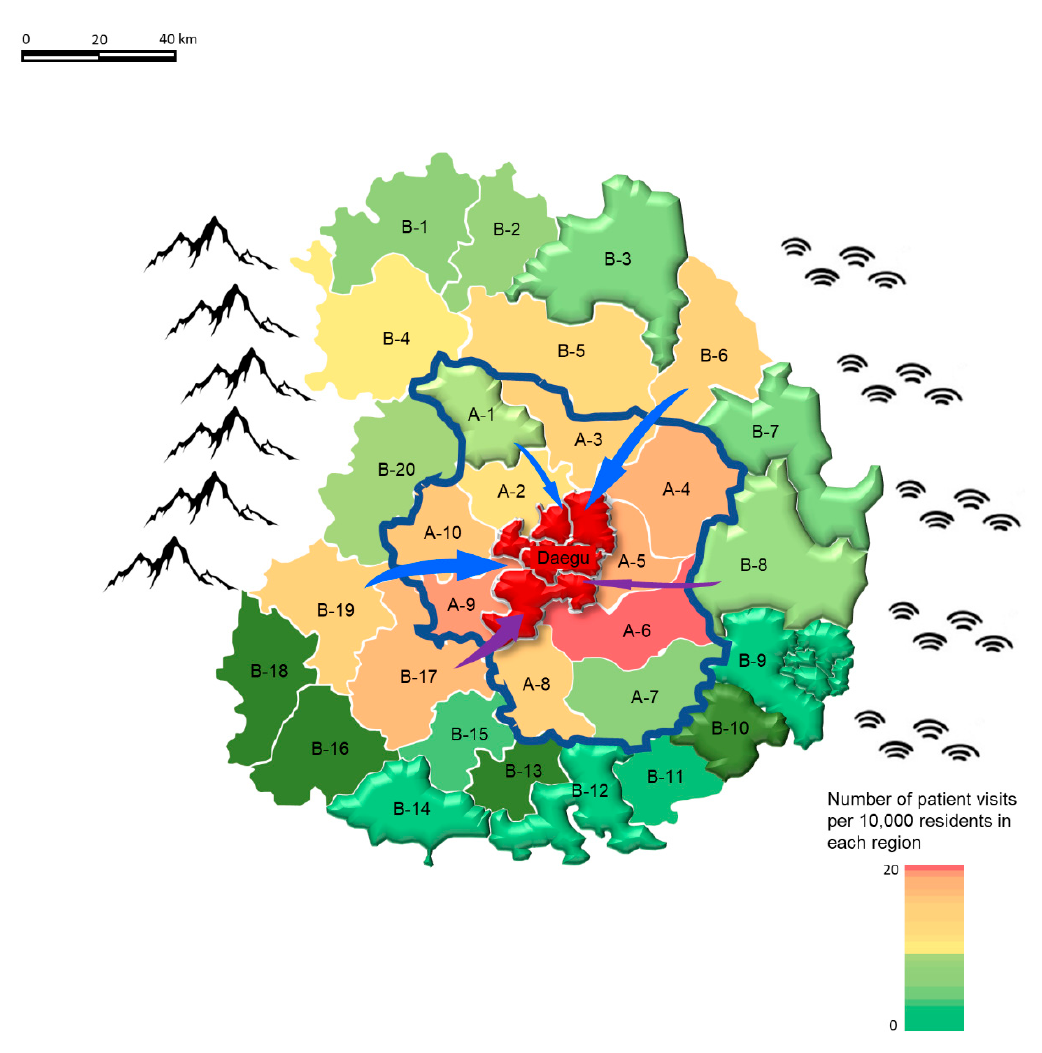
Figure 2. Number of patient visits per 10,000 residents in each region outside the metropolitan city. (Among the neighboring provinces, areas less than 45 km away from the Daegu Metropolitan City are marked as “A”, and those farther than 45 km are marked as “B”. Each subregion within A and B was identified by marking the letter with a number, “-n”, in clockwise order. Regions that operated at least one isolation room are shown in three